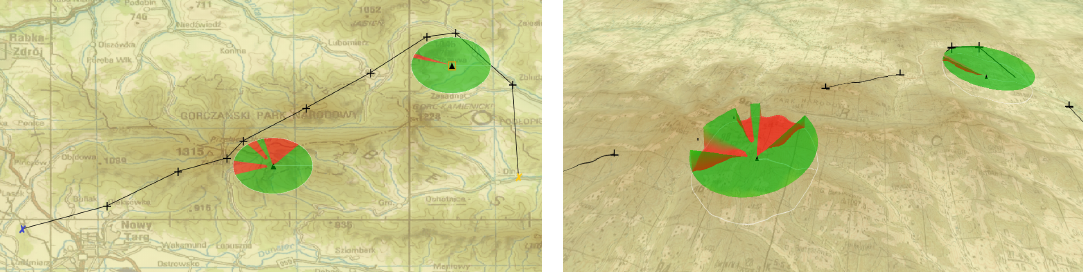
Figure 9. Example of a mission plan presented in 2D and 3D in upland